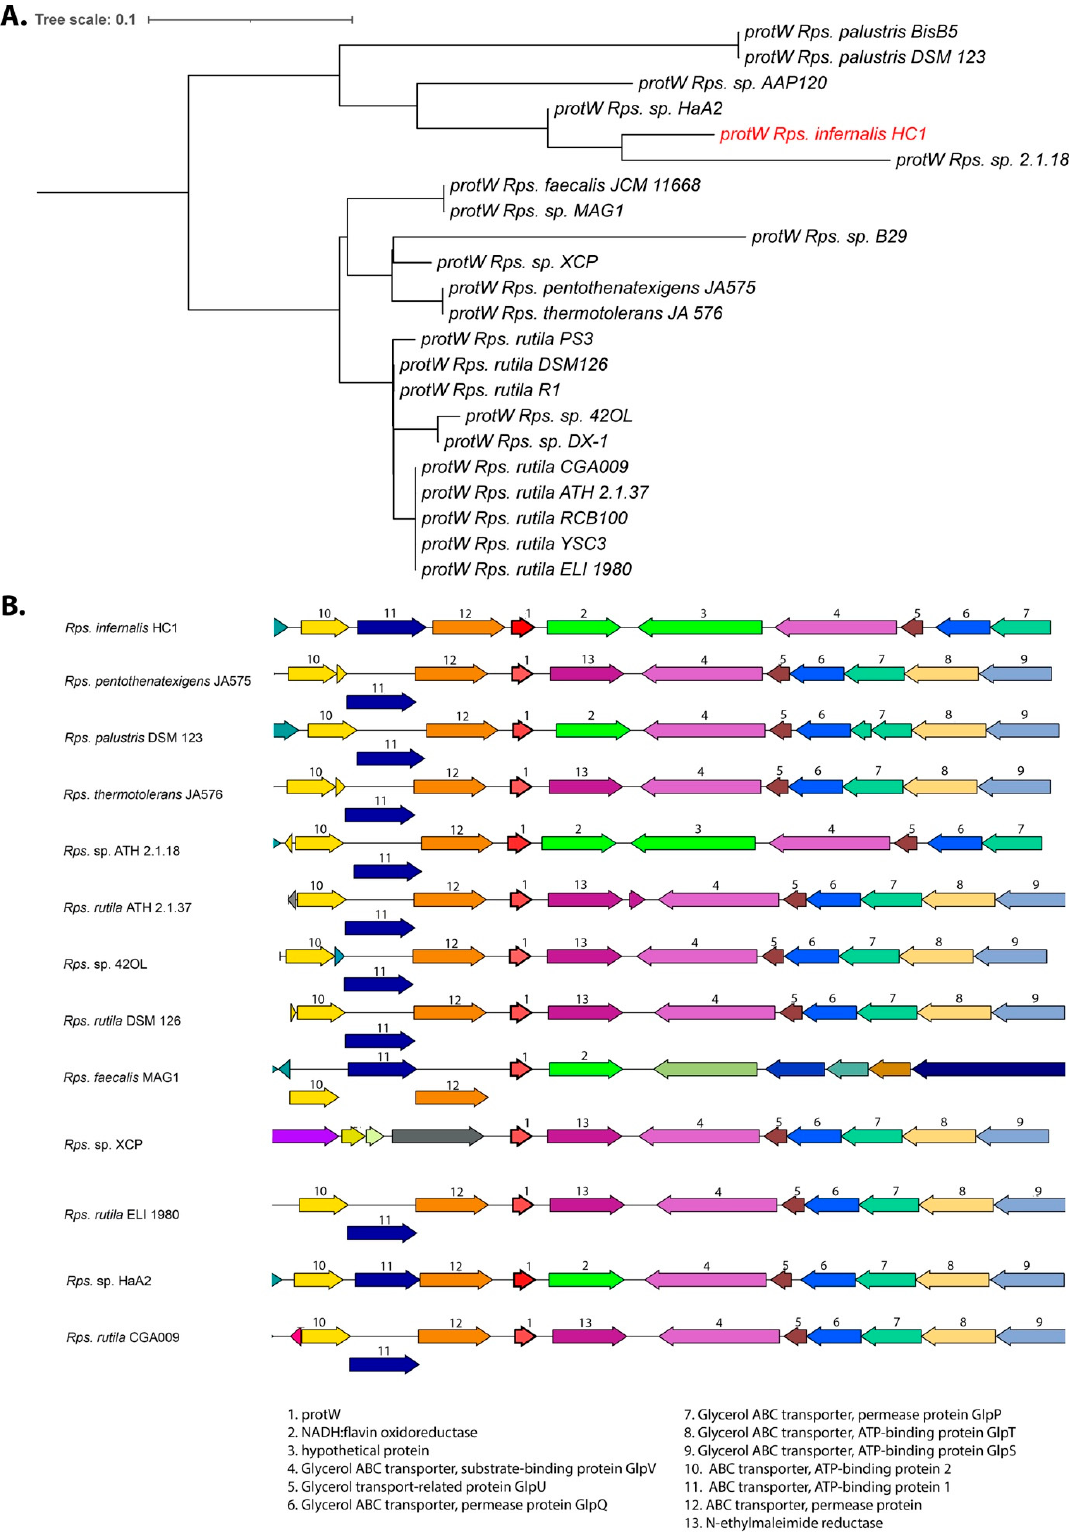
Figure 4. ( A ) Phylogenetic comparison of the protein W amino acid sequences of all sequenced Rhodopseudomas species. The tree was rooted at midpoint. Strain HC1 protW is indicated in red. ( B ) Synteny analysis of the protW gene area of Rhodopseudomonas species related to isolate HC1. Genes are colored based on their family